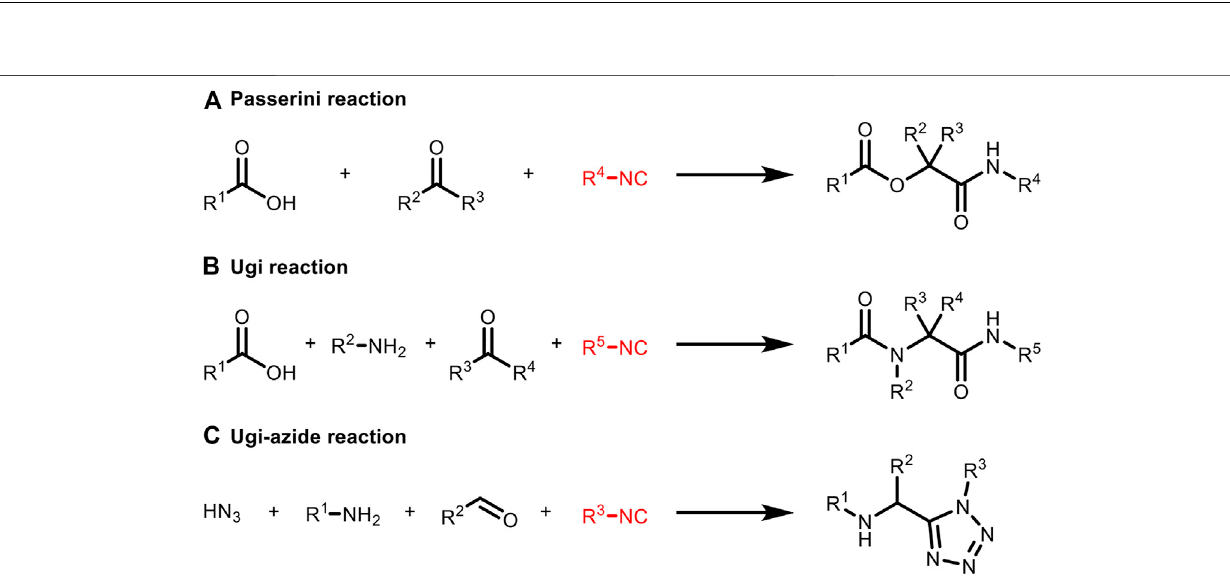
Frontiers in Chemistry |